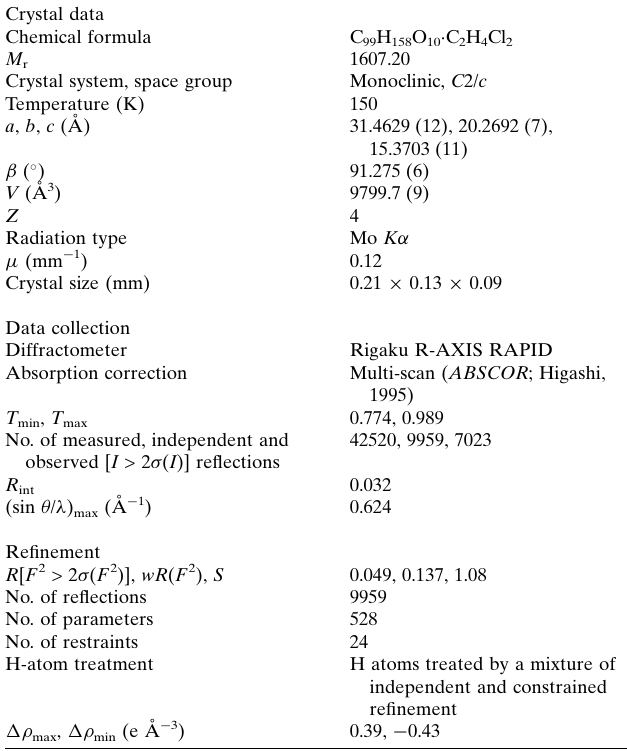
Crystal data Chemical